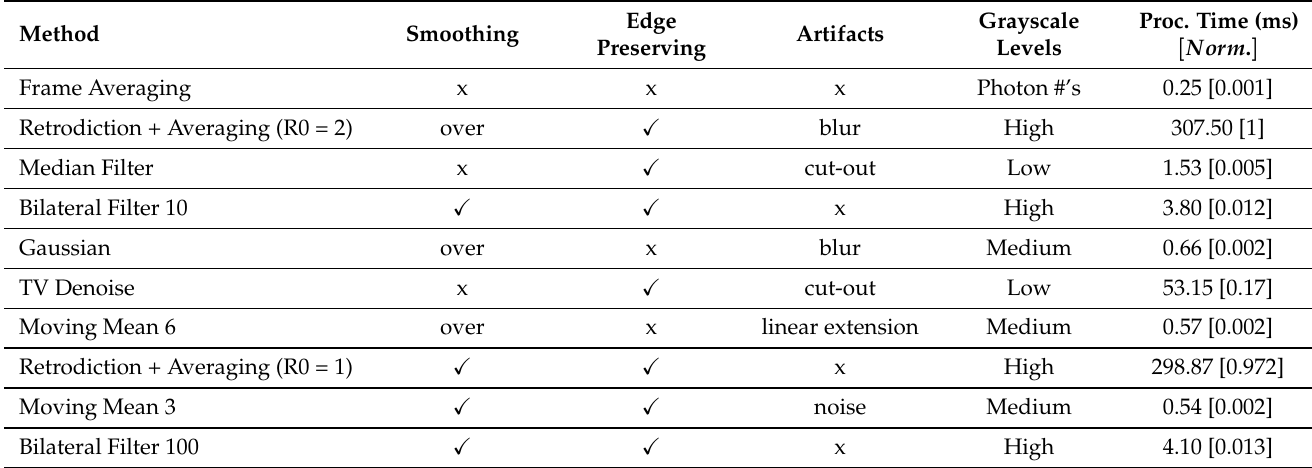
Table 1. Comparison of Image Reconstruction Methods (Ordering to match Figures 8 and